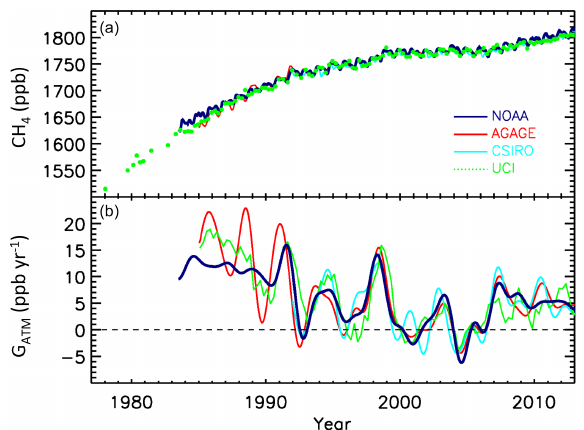
Figure 1. Globally averaged atmospheric CH 4 (ppb) (a) and its annual growth rate G ATM (ppbyr − 1 ) (b) from four measure- ment programmes: National Oceanic and Atmospheric Adminis- tration (NOAA), Advanced Global Atmospheric Gases Experiment (AGAGE), Commonwealth Scientific and Industrial Research Or- ganisation (CSIRO), and University of California, Irvine (UCI). Detailed descriptions of methods are given in the Supplement of Kirschke et al.